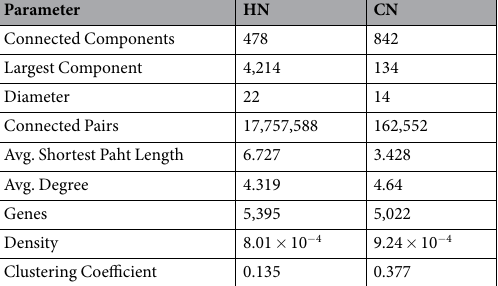
Table 1. Network parameters for Healthy (HN) and Cancerous (CN) phenotypes. Notice that the network diameter as well as the connected pairs (100 × ) are considerably larger in HN with respect to CN. It is opposite to the case for the number of connected components.